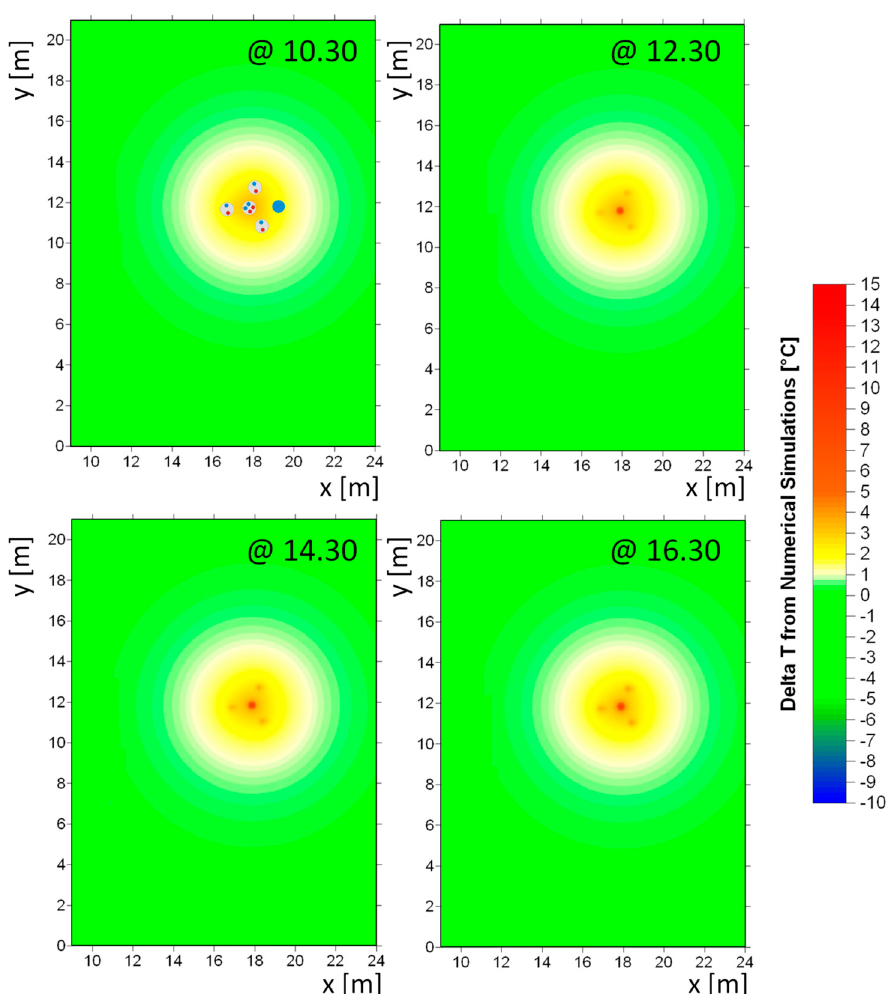
Figure 5. Temperature differences obtained from the numerical simulations for four different time steps during the monitoring day. The location of BHEs is reported in the first panel.